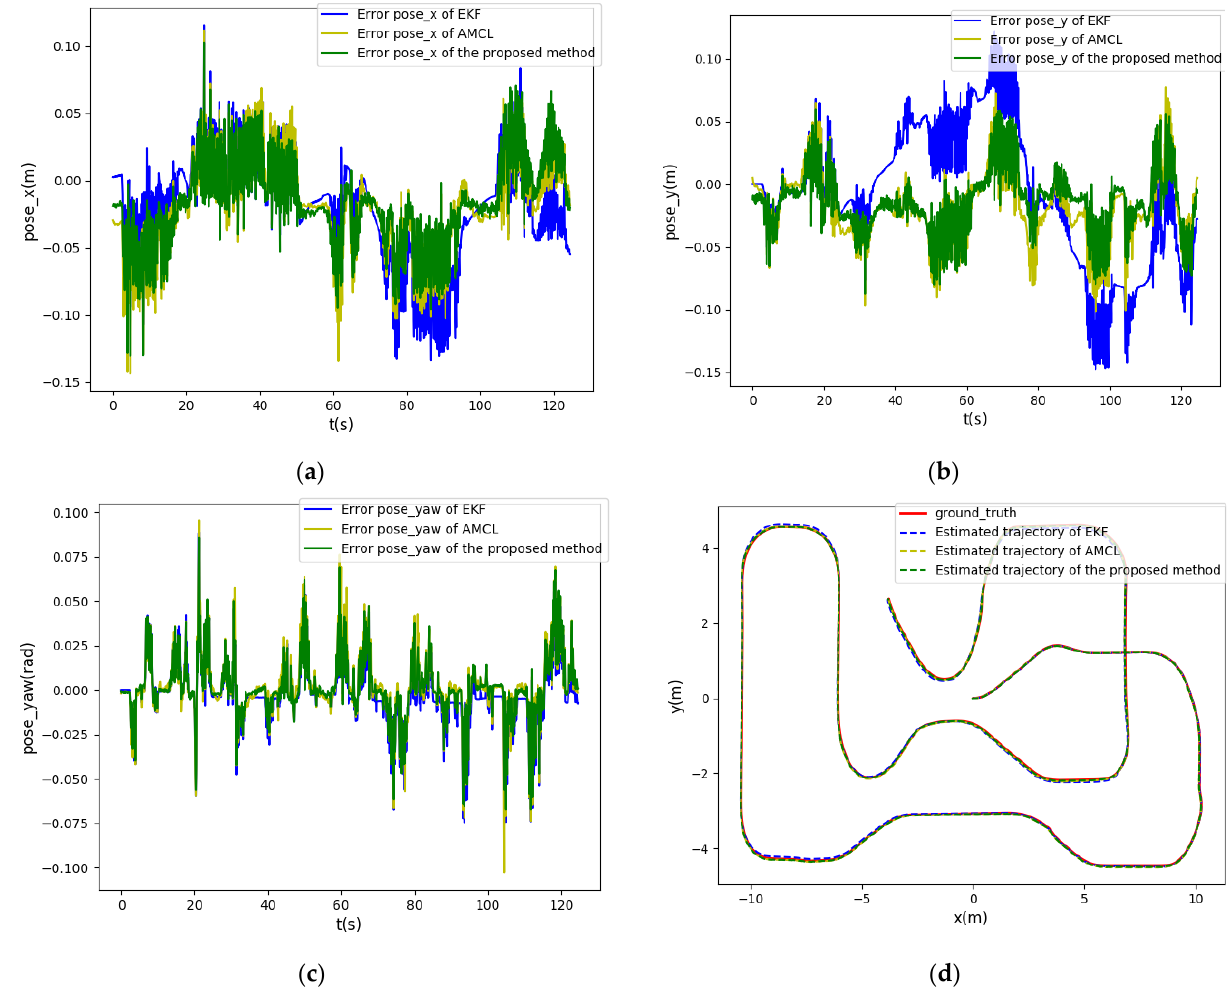
Figure 11. The pose estimation result of case 1. ( a ) The estimated error in x direction; ( b ) The estimated error in y direction; ( c ) The estimated error in the yaw direction; ( d ) True trajectory and estimated trajectory. Table 2. The results of the pose estimation errors in case 1 and case 2, respectively.